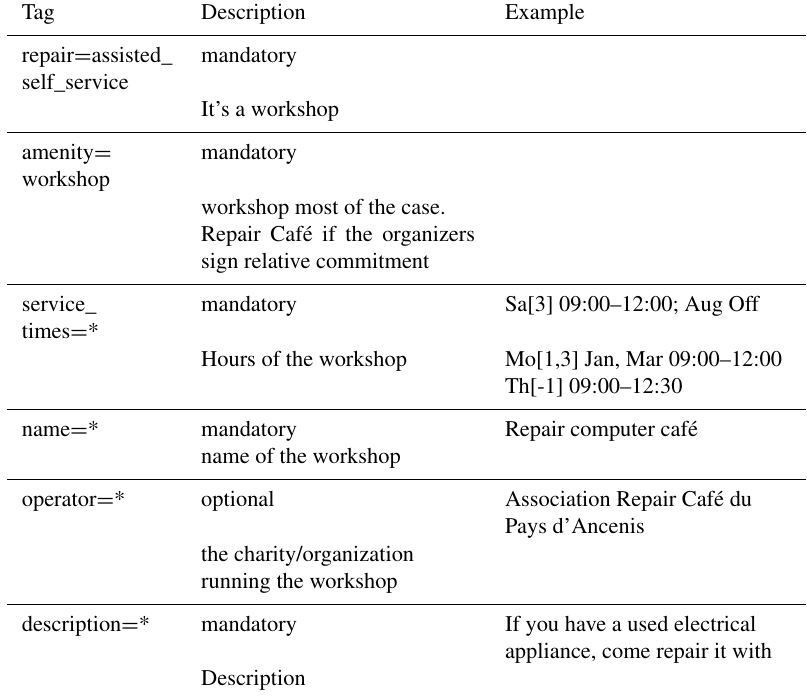
Table 4. Some tags of the consumer OpenStreetMap project “CircularEconomy”